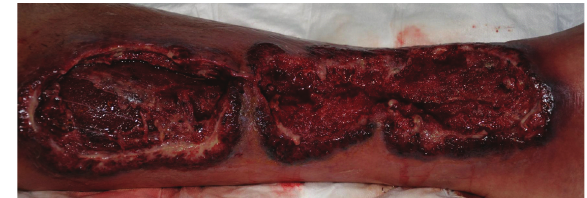
Figure 2: Wound appearance after extensive debridement, at the upper wound pole, the gastrocnemius muscle is exposed.